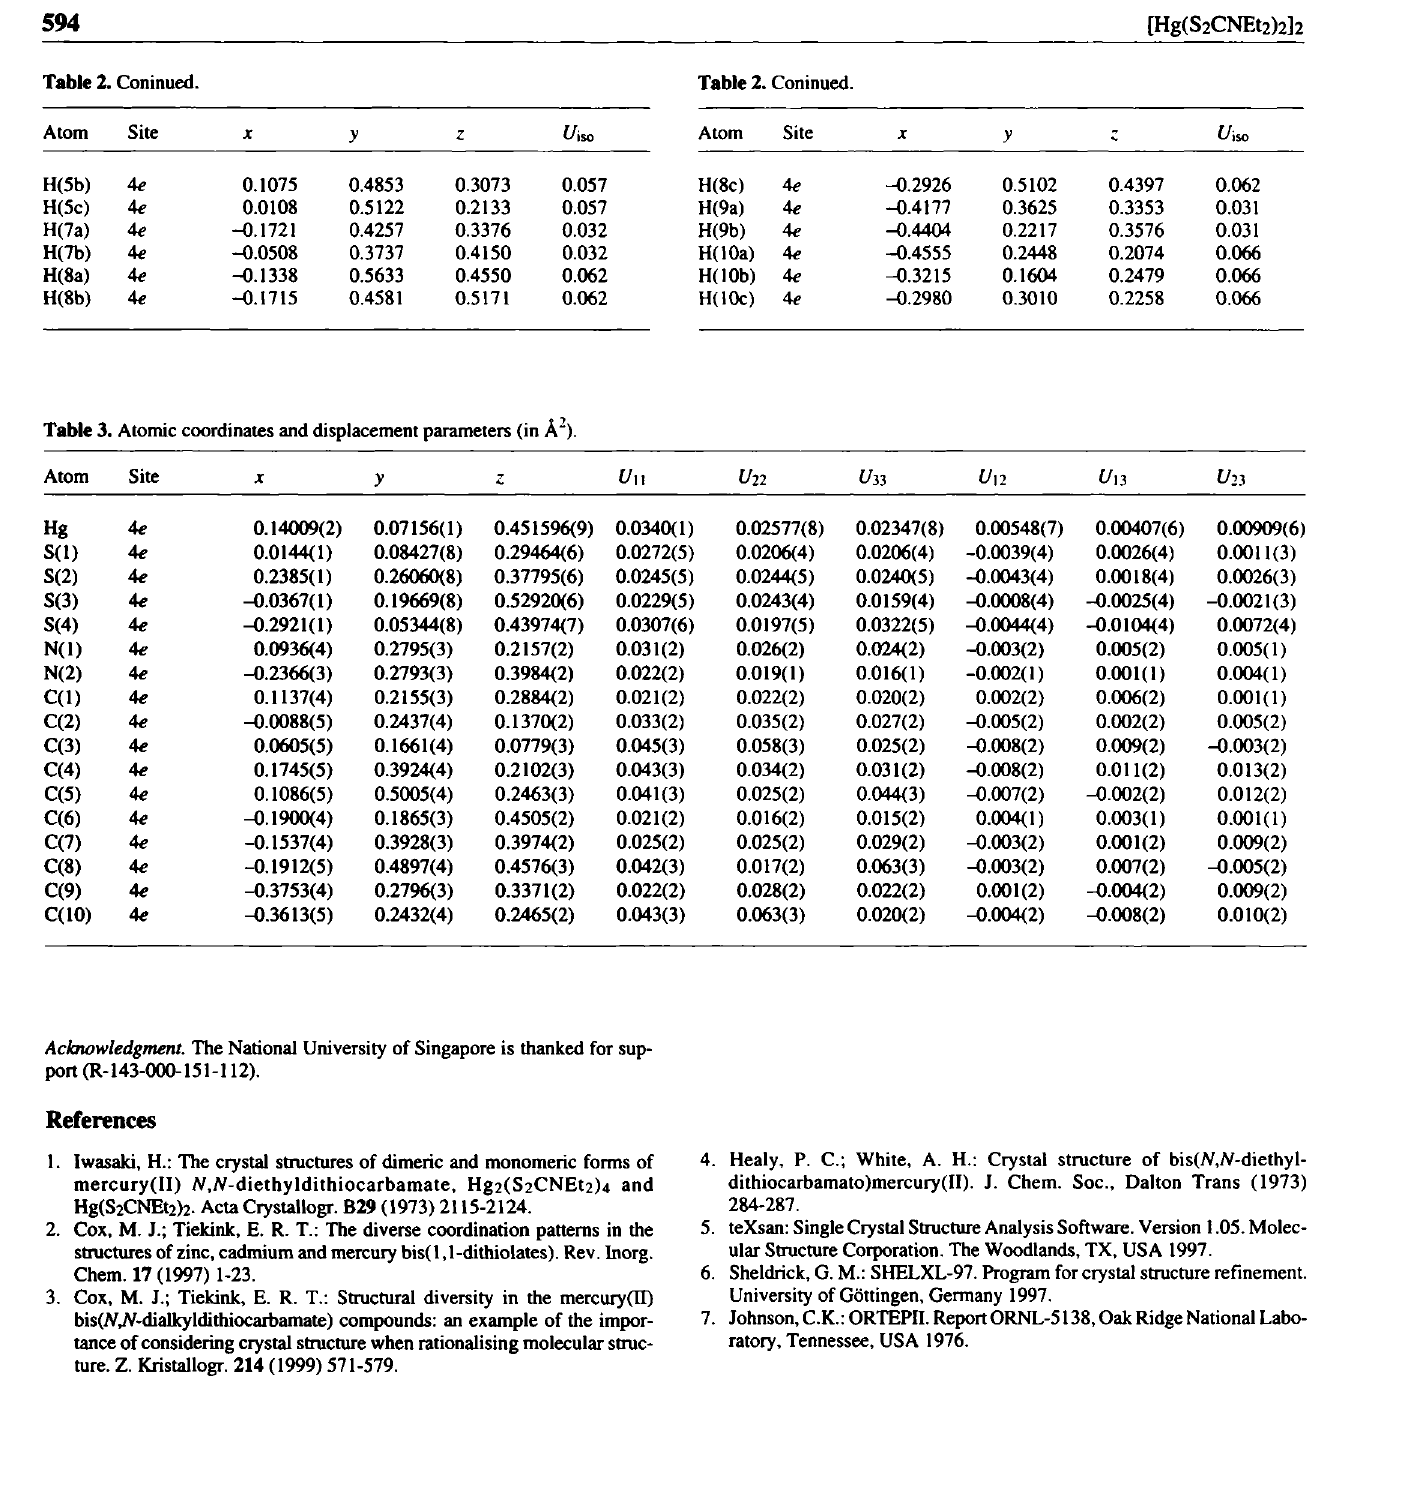
Table 3. Atomic coordinates and displacement parameters (in Â 2